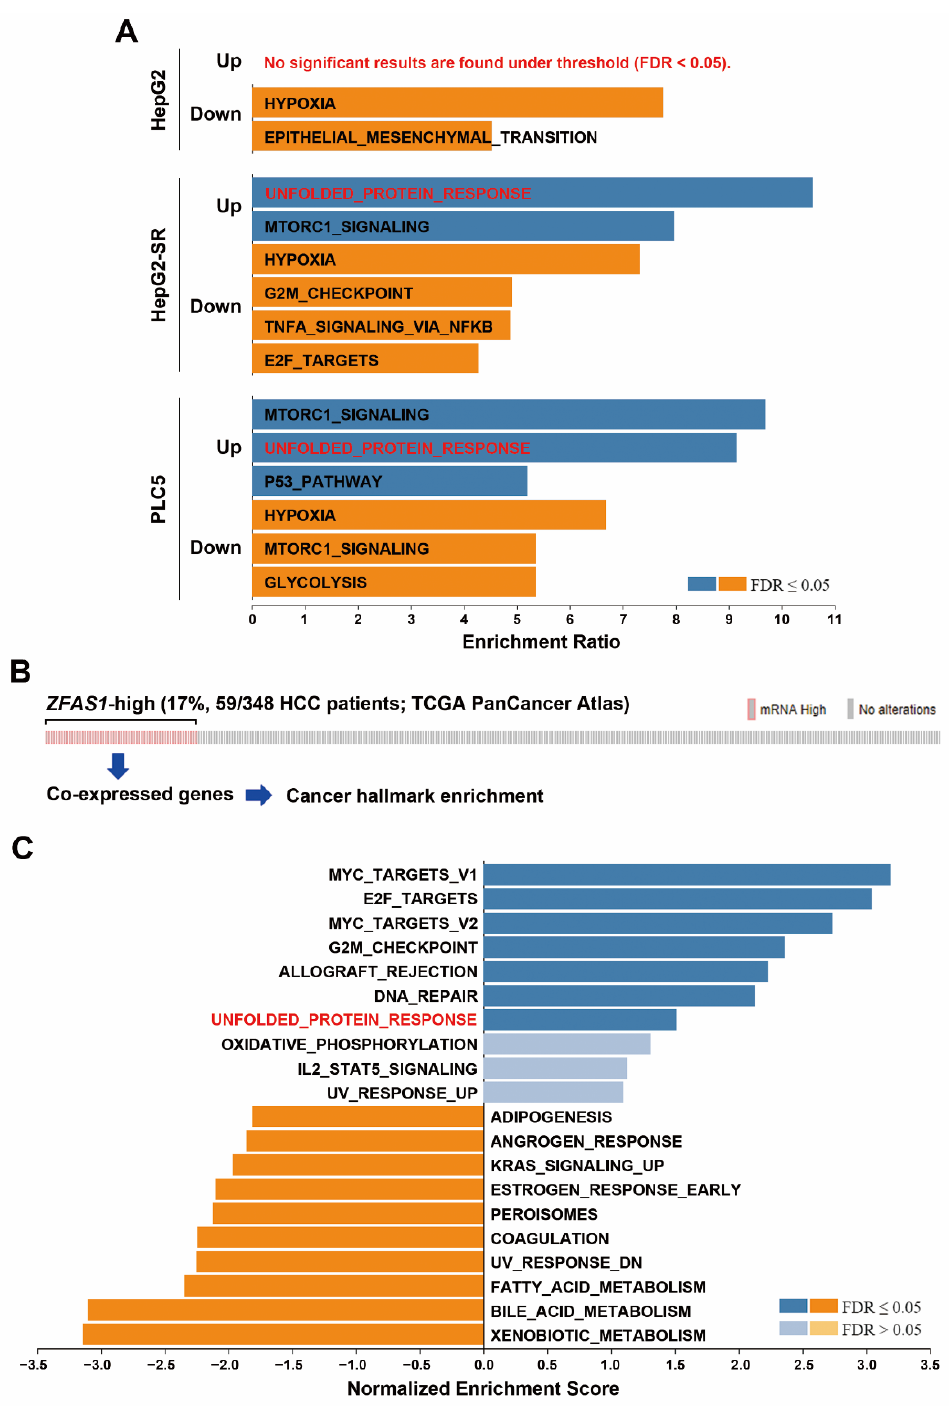
Figure 5. Pathway enrichment for ZFAS1 -associated cancer hallmark. ( A ) The RNA-sequencing data in Table S1 were analyzed using the WebGestalt for cancer hallmark analysis. ( B ) The OncoPrint for ZFAS1 mRNA expression in TCGA-LIHC dataset. ( C ) The over- and under-expressed genes in ZFAS1 -high expressing HCC patients were obtained from the cBioPortal website and these genes were analyzed using the WebGestalt for cancer hallmark analysis.